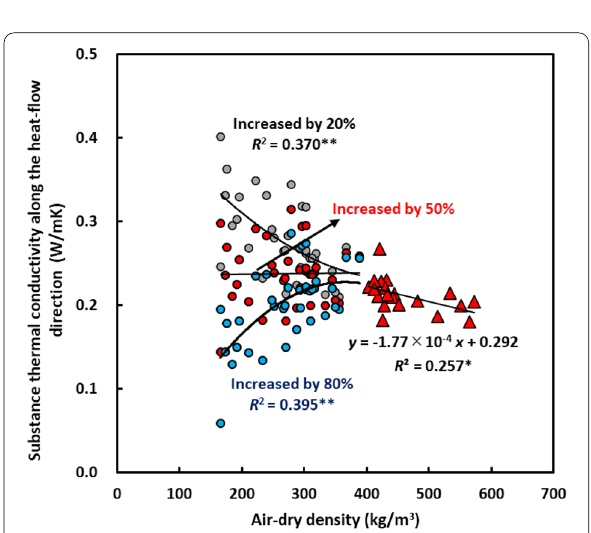
Fig. 11 Waste mushroom bed’s estimated substance thermal conductivity along the heat-flow